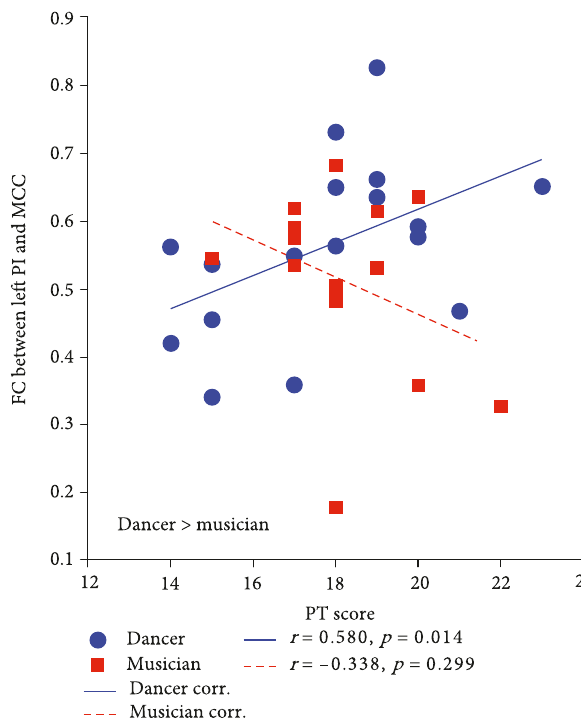
Figure 4: The positive associations between C-IRI scores and FC in the dancer group. Linear partial correlation coe ffi cients between FC (left PI and MCC) and PT scores in dancers (blue solid line) and musicians (red broken